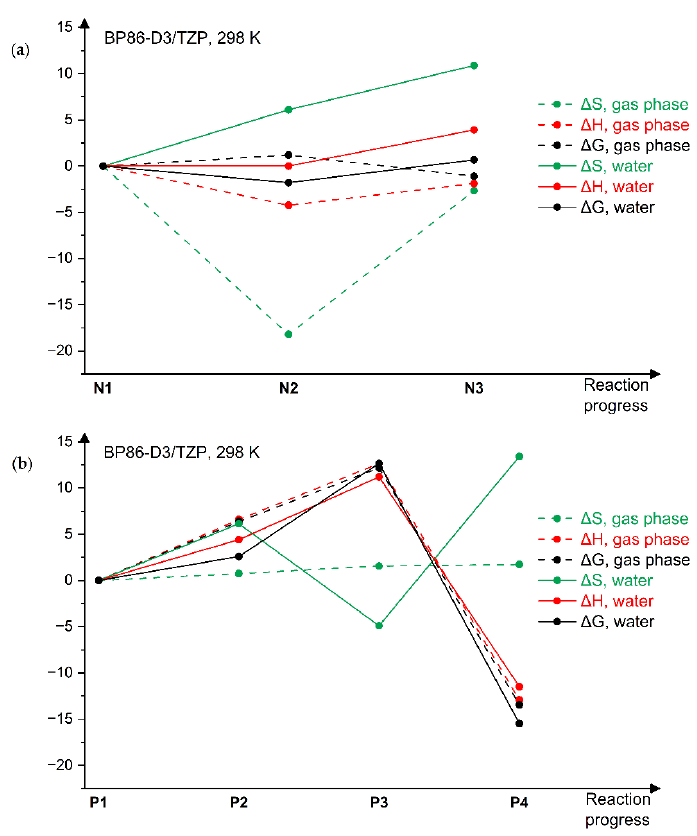
Figure 11. Enthalpy (red lines) and entropy (green lines) contributions to Gibbs free energies (black lines) of ( a ) nylon 6 and ( b ) PHB structures obtained for gas phase (dashed lines) and water presence (solid lines) in 298 K.